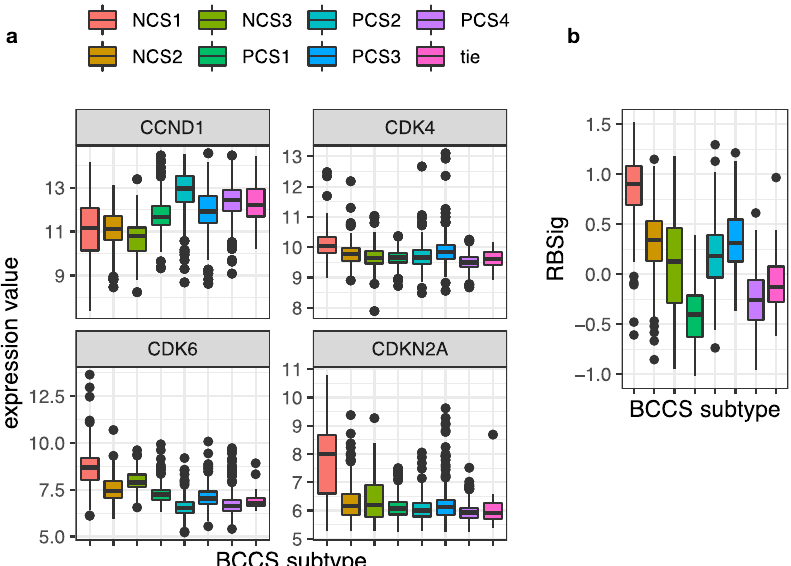
Fig. 8 Distribution by BCCS subtypes in METABRIC for expression of genes related to CDK4/6 inhibitor activity, and the RBSig signature. a This fi gure plots distributions by BCCS subtypes in METABRIC of the expression levels of CCND1, CDK4, CDK6, and CDKN2A, which have been associated with CDK4/6 inhibitor activity. b This plots the degree of variation in values of the RBSig score by BCCS subtype of METABRIC. The RBSig score was created to measure the likelihood of resistance to CDK4/6 inhibitors. The midline in a boxplot indicates the median, the upper and lower edges indicate the quartiles, and the whisker lines are 1.5 times the interquartile